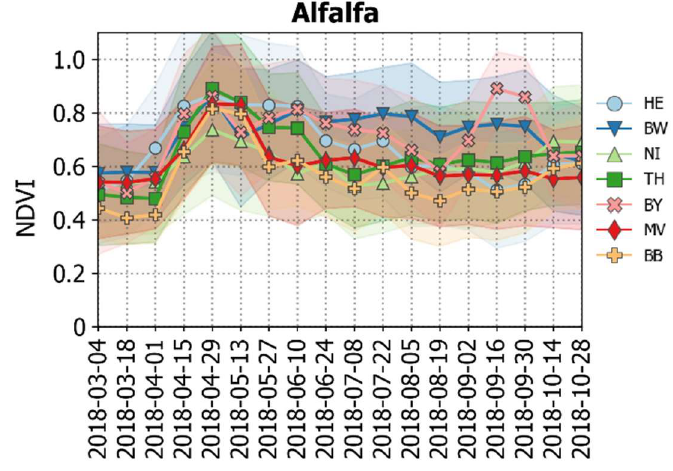
Figure 10. NDVI temporal profile of class alfalfa across seven study sites.